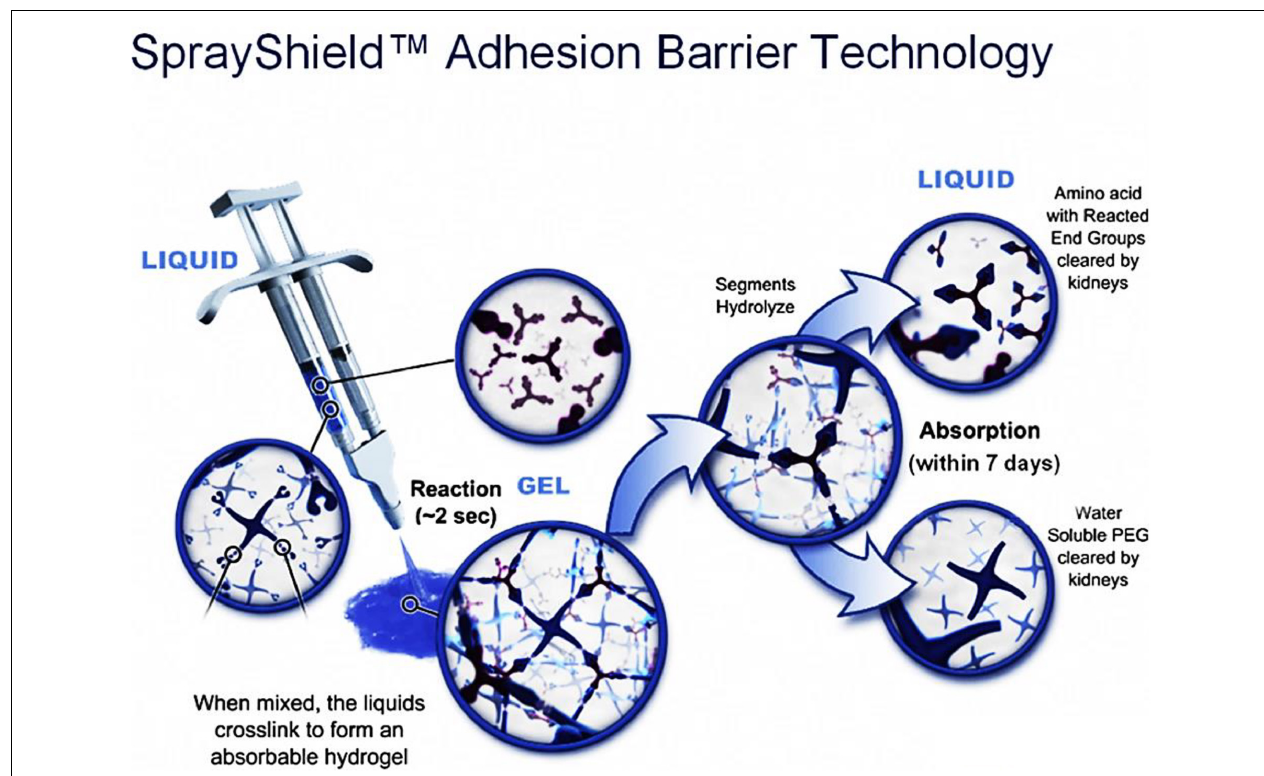
FIGURE 4 | A schematic overview of DuraSealTM with a two-component system of tetra-PEG and trilysine. Reproduced from Ghobril and Grinstaff (2015) with permission from Copyright 2015 Royal Society of Chemistry.